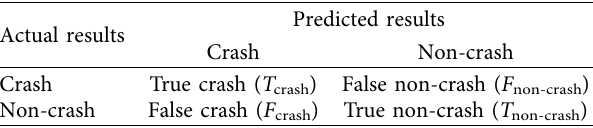
Figure 6: Ranking of the importance of variables. Table 2: Te confusion matrix of prediction